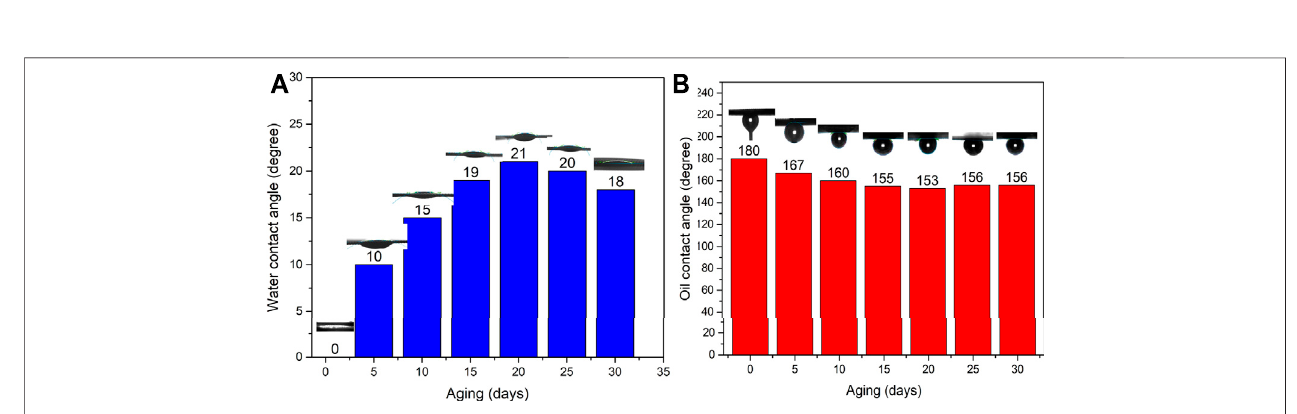
FIGURE 7 | Effect of aging time on the water contact angle (WCA) (A) and OCT (B) of the zeolite-coated laser-structured SS-100 meshes.